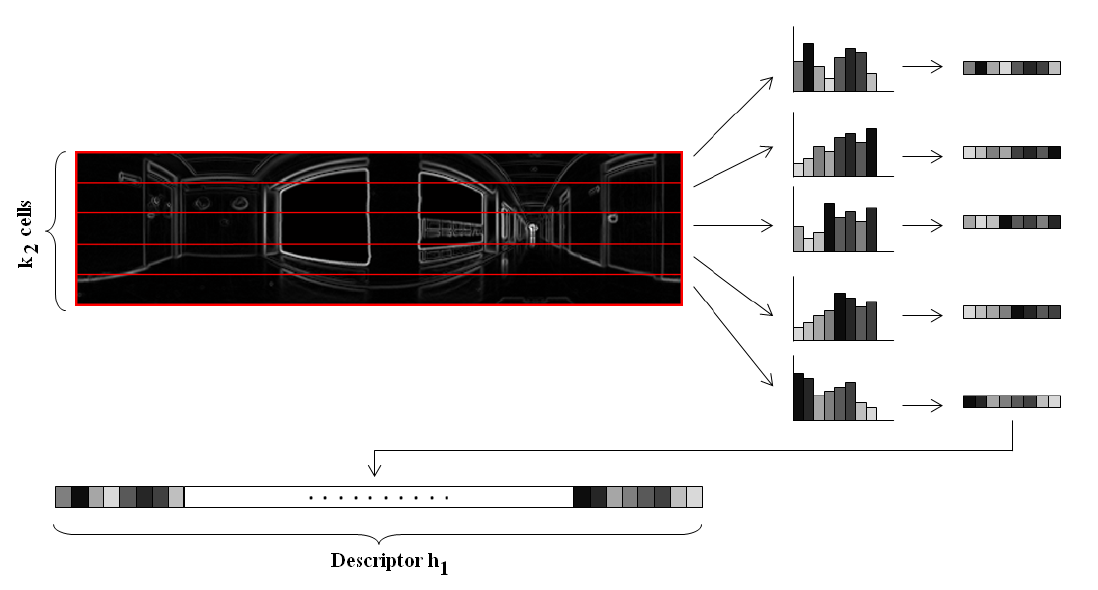
Figure 3. Distribution of horizontal cells on a panoramic image to build a rotationally invariant descriptor (cid:126) h 1